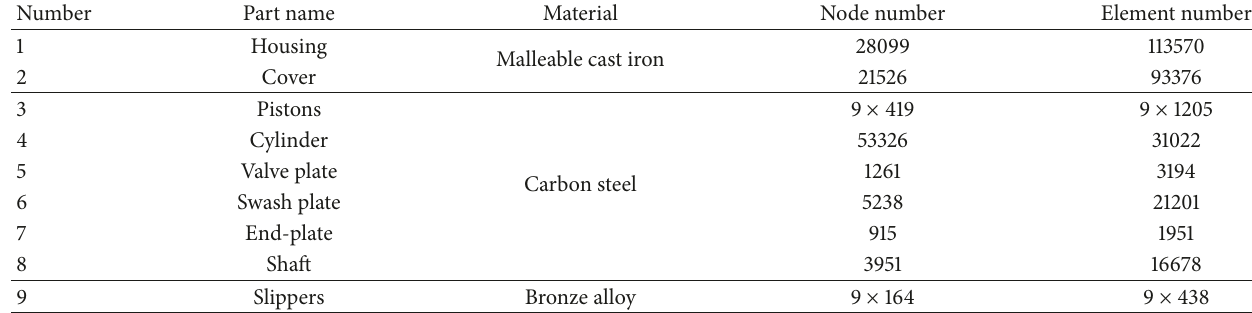
Table 1: Detailed information of the structural FE